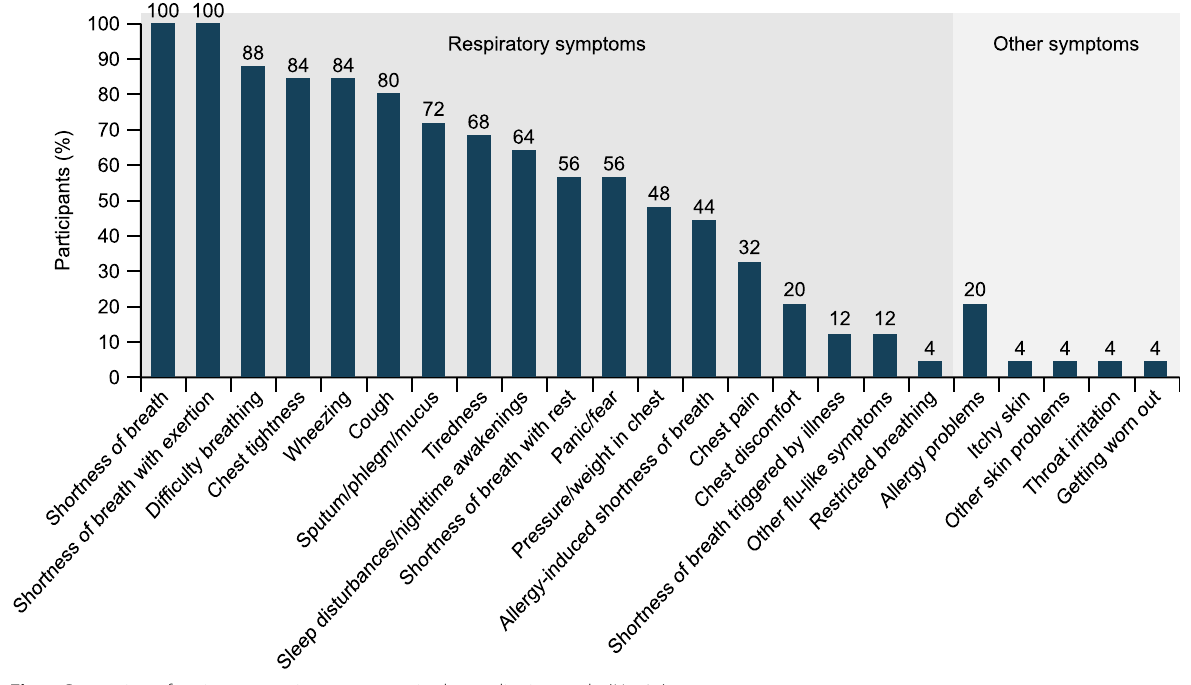
Fig. 1 Proportion of patients reporting symptoms in the qualitative study ( N =